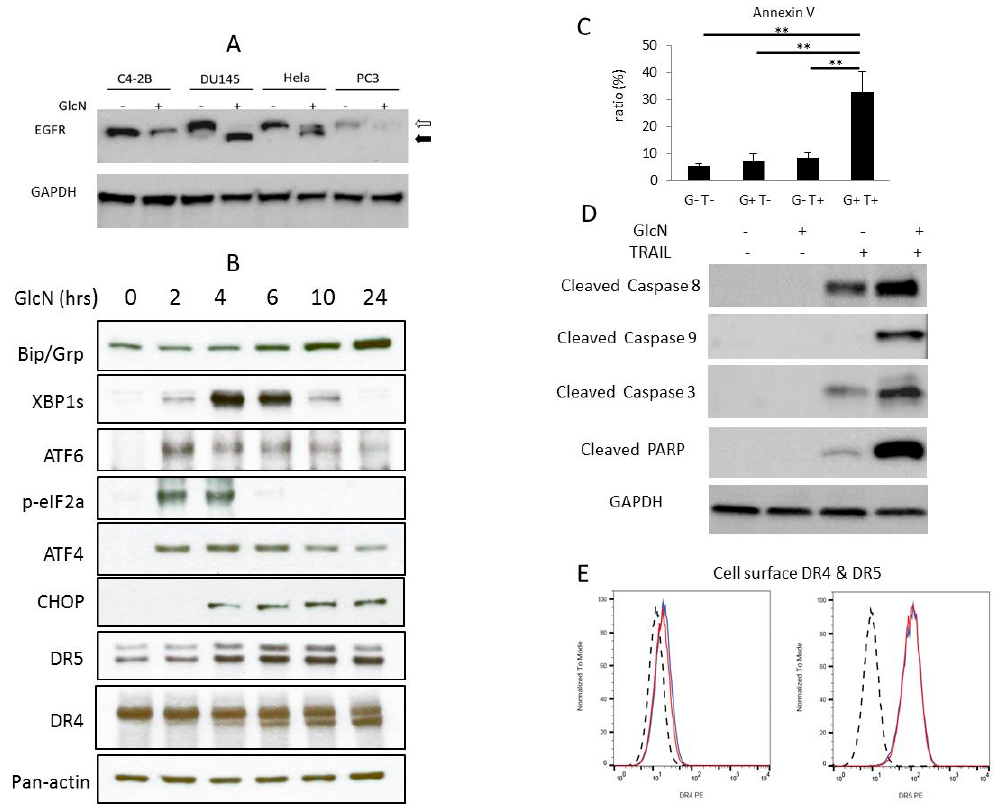
Figure 1. Glucosamine (GlcN) increases expression of multiple apoptosis e ff ectors and synergizes tumor necrosis factor (TNF)-related apoptosis-inducing ligand (TRAIL)-induced apoptosis. ( A ) Sensitivity of di ff erent cell lines to GlcN-induced deglycosylation as measured by EGFR. C4-2B, DU145, HeLa and PC3 cells were cultured in the presence of 2 mM GlcN for 24 h. Whole-cell lysates were subjected to immunoblotting using an EGFR antibody. The open arrow indicates the N-glycosylated EGFR receptor and the filled arrow indicates the deglycosylated receptor. ( B ) DU145 cells were grown in 2 mM GlcN for the indicated time and whole-cell extracts were prepared and analyzed by immunoblotting using antibodies against DR4 and DR5 and multiple unfolded protein response (UPR) indicators (Bip, XBP1s, ATF6, p-EIF2a, ATF4, CHOP) and pan-actin. ( C ) Untreated (G– / T–) cells or cells treated with 2 mg / mL GlcN for 24 h (G + T–), 50 ng / mL TRAIL for 8 h (G–T + ) or a combination of both GlcN for 24 h then TRAIL for 8 h (G + T + ) were stained with annexin V / PI and then analyzed by flow cytometry analysis. Bars represent the mean value of three independent assays, ** p < 0.01. ( D ) Whole-cell extracts were analyzed by immunoblotting with cleaved caspases 8, 9 and 3, PARP and GAPDH after treatment as in 1C. ( E ) Flow cytometry analysis of cell surface DR4 / DR5 treated with 2 mM GlcN.